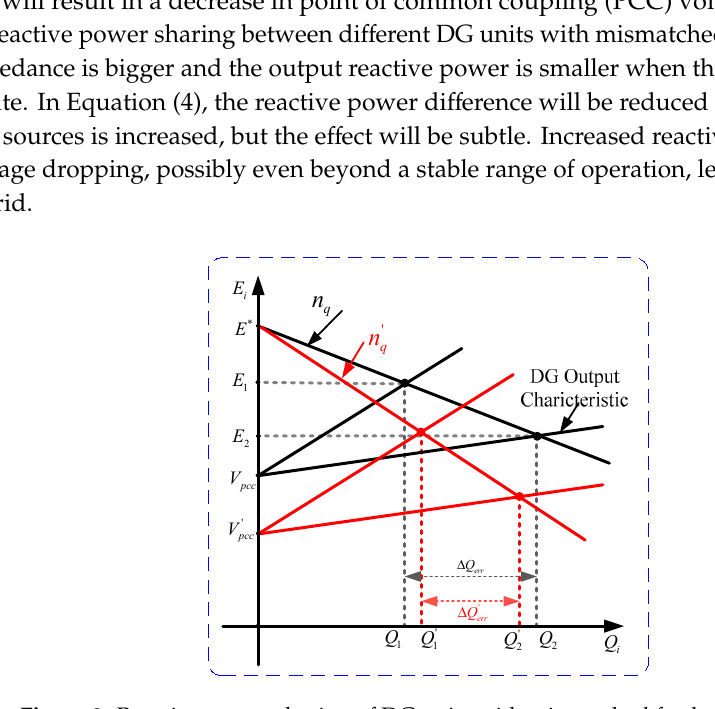
Figure 3. Reactive power sharing of DG units with mismatched feeder impedance.